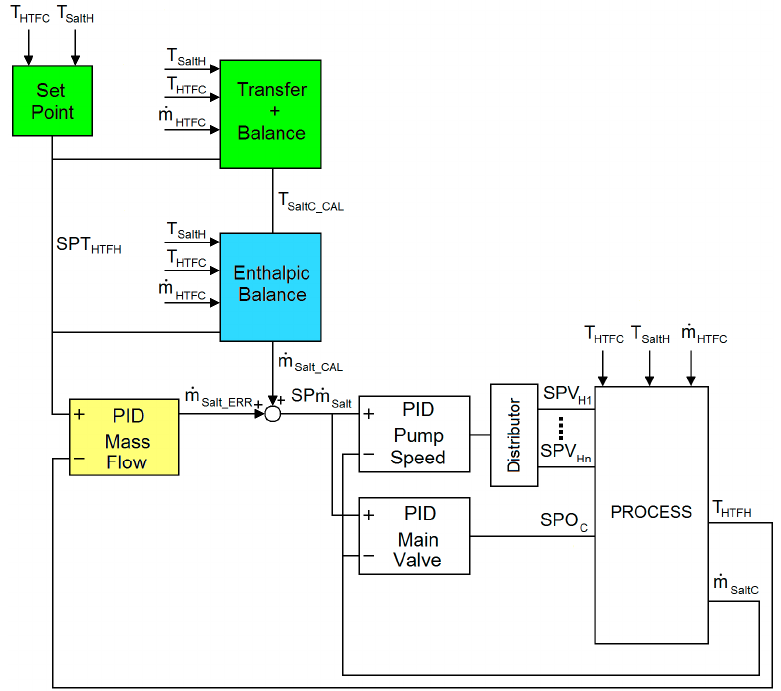
Figure 6. Advanced PID control with feed-forward (discharge process).